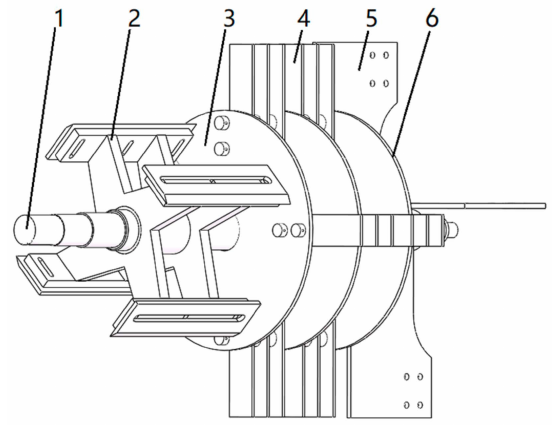
Figure 1. Three-dimensional model of the spindle rotor. (1) Spindle; (2) disc cutter; (3) hammer frame; (4) hammer; (5) throwing blade; (6) support plate.